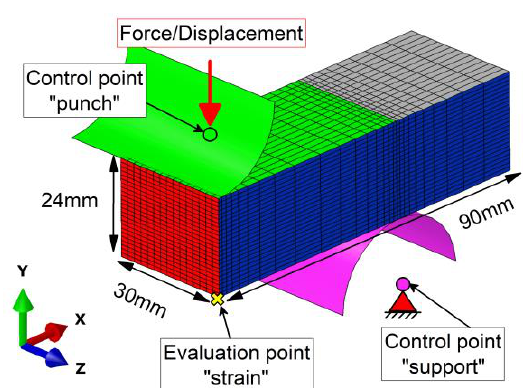
Figure 3. Simulation setup with finite element (FE) mesh, boundary conditions, and loads. The red triangle represents fixed translational and rotational degrees of freedom for the control point “support.” The red vertical arrow represents the applied force or displacement in the y-direction on the control point “punch.” The other translational and rotational degrees of freedom are fixed for the punch as well. The visual surfaces the in x- and z-directions represent symmetry planes to keep computational costs low.